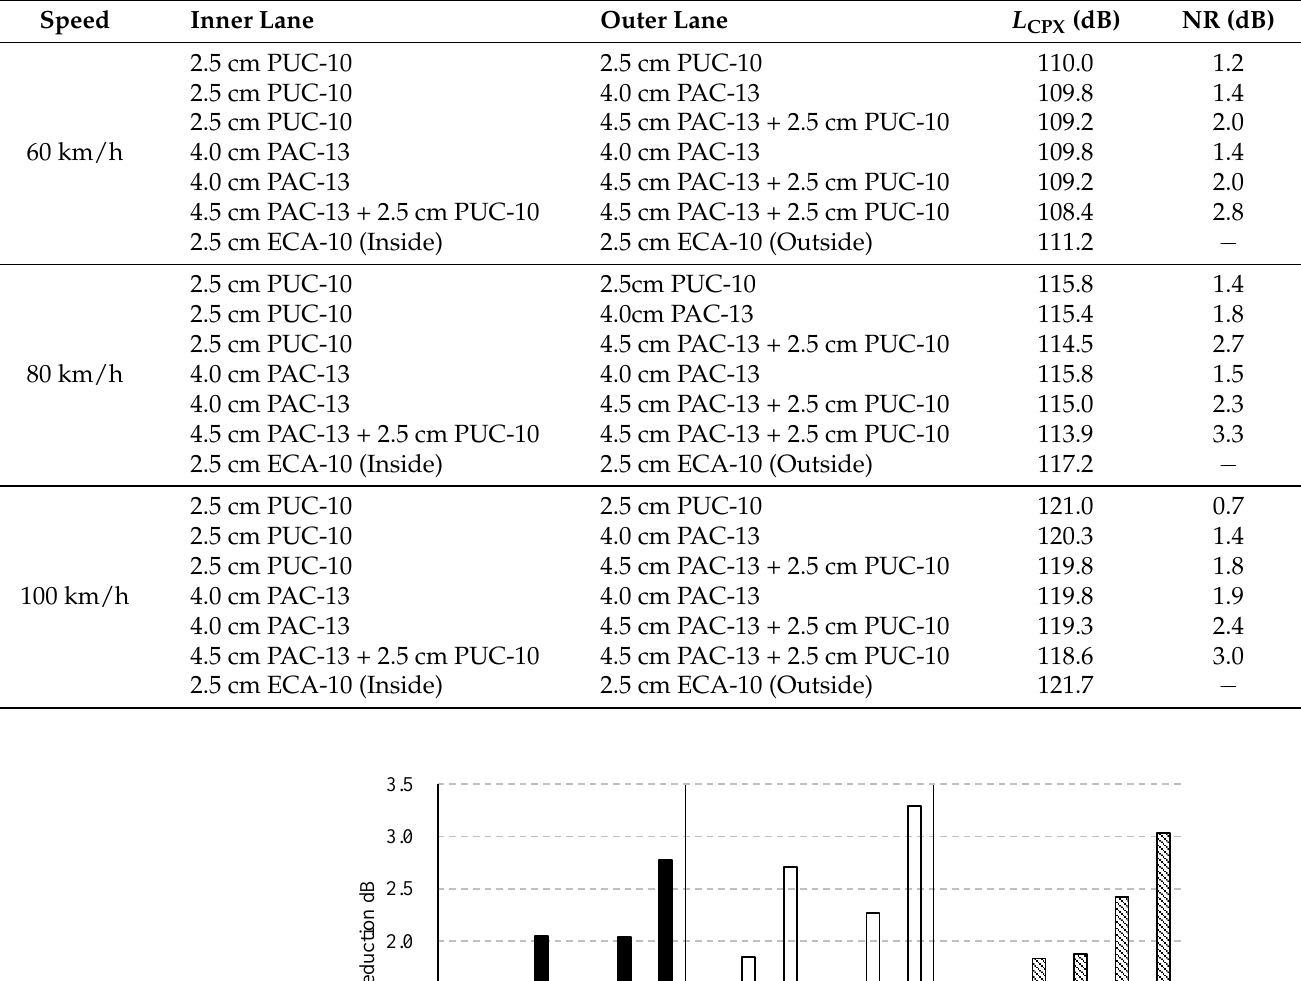
Table 3. L CPX of composite pavement at the same speed in two nearby lanes.